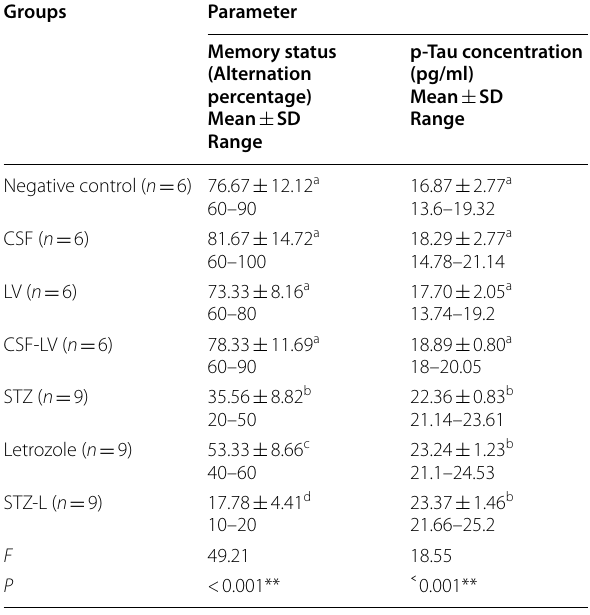
Table 1 Alternation percentage and p‑Tau concentration among the studied groups